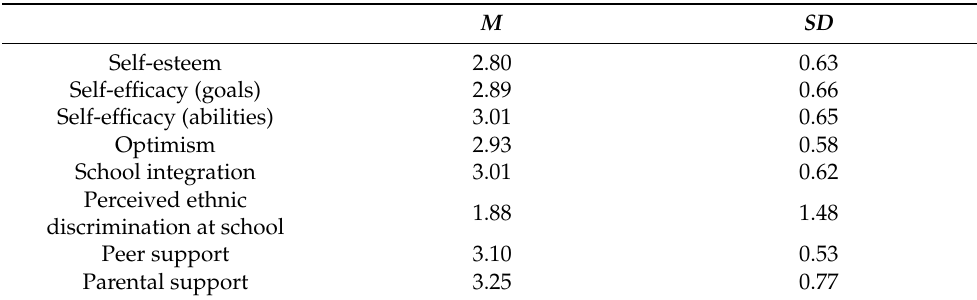
Table 1. Means and standard deviations of our main study variables ( N =